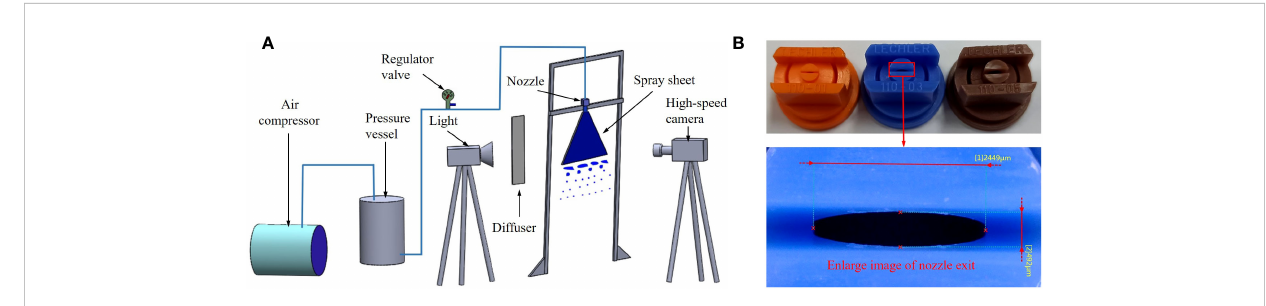
FIGURE 1 (A) Schematic view of experimental apparatus. (B) Nozzle image and enlarged image of nozzle